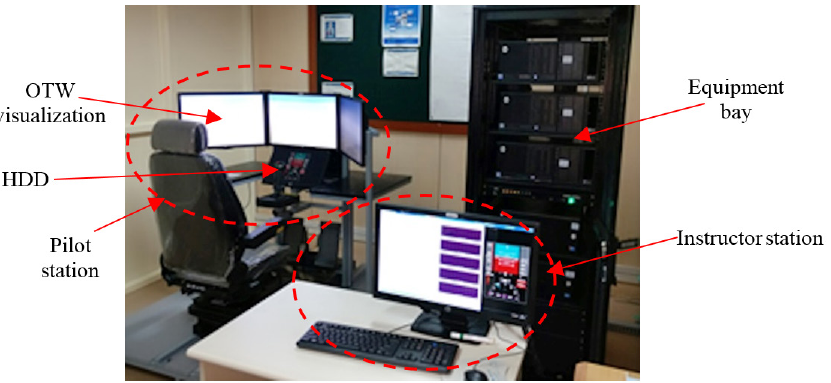
Figure 1. Framework for NALSim flight simulator